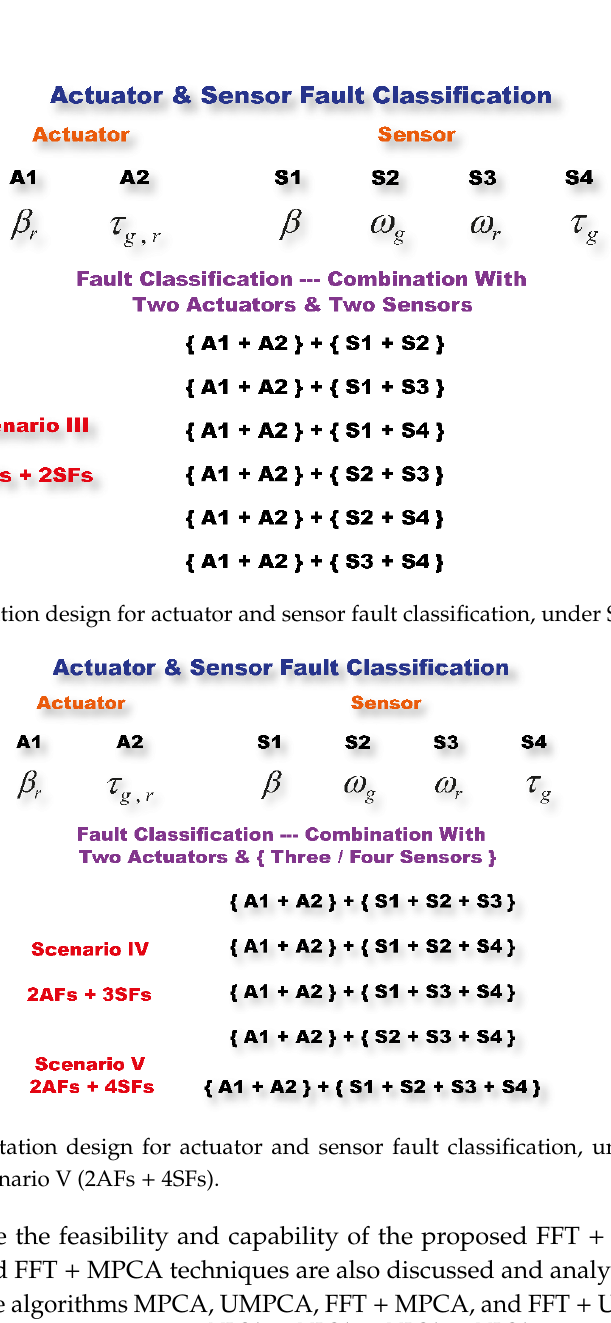
Table 5. Datasets of experimentations with AWGN noises based on different topologies of the data- driven methodologies: MPCA and UMPCA.